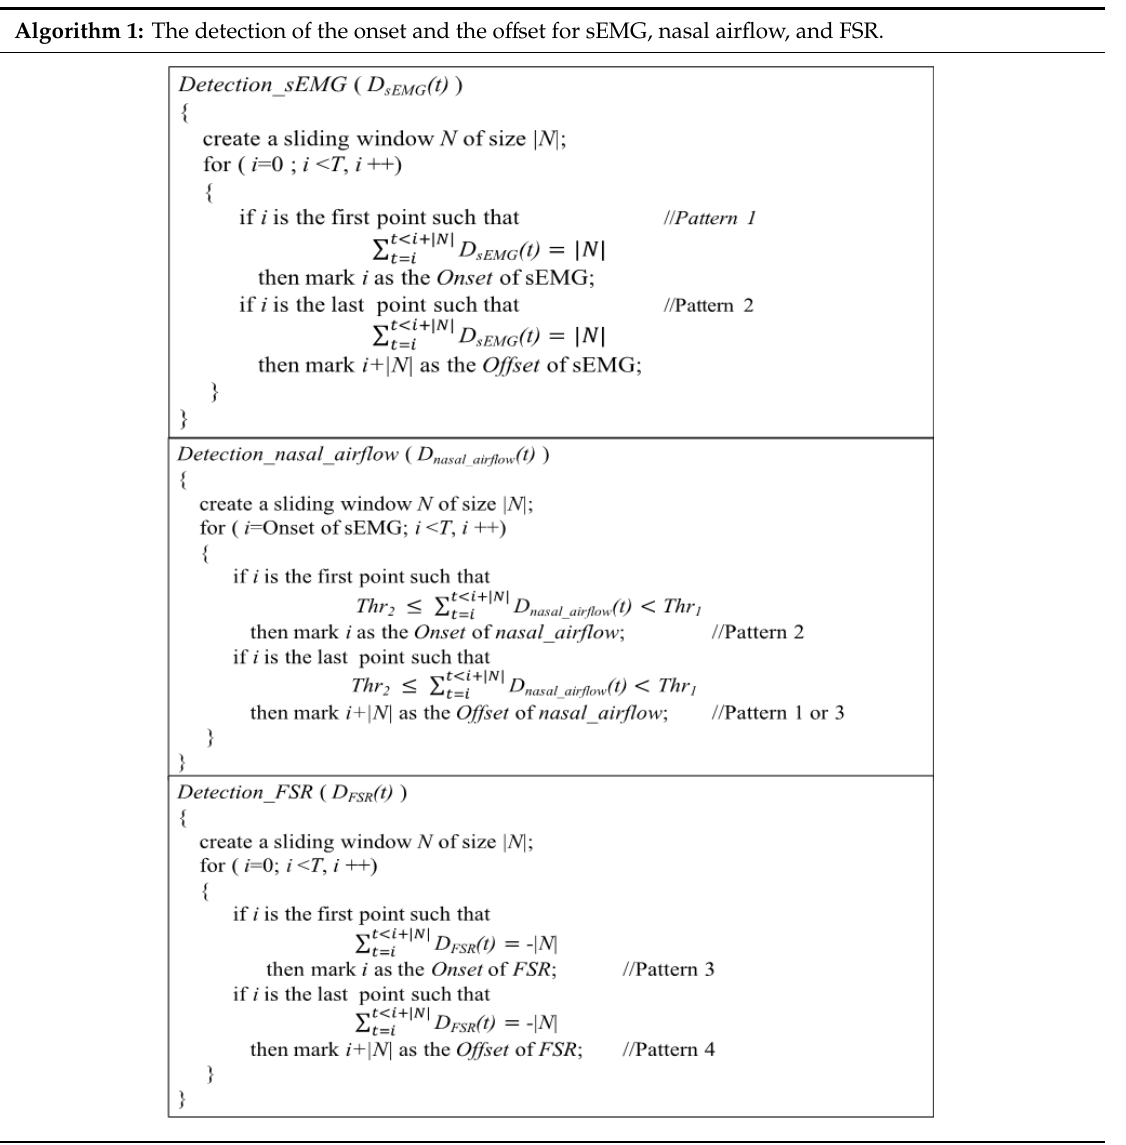
Sensors 2019 , 19 , x FOR PEER REVIEW 6 of